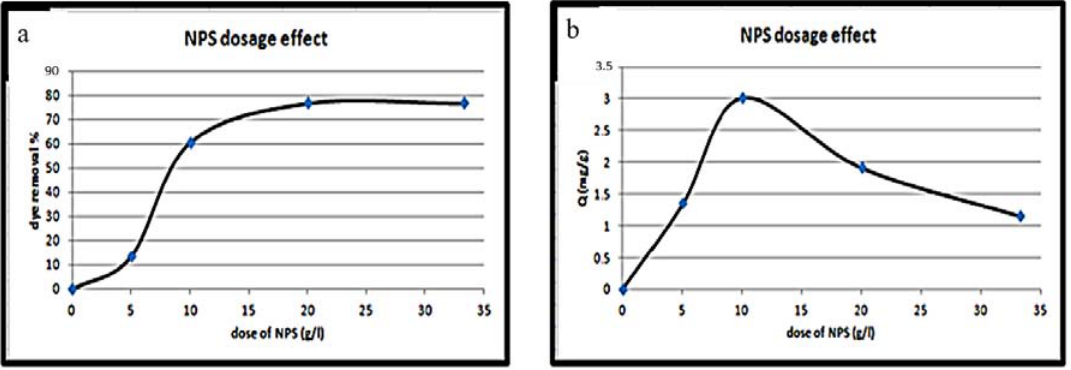
Figure 9. Effect of NPS dosage on: ( a ) CR dye removal, ( b ) the quality of the adsorption process, at initial dye concentration